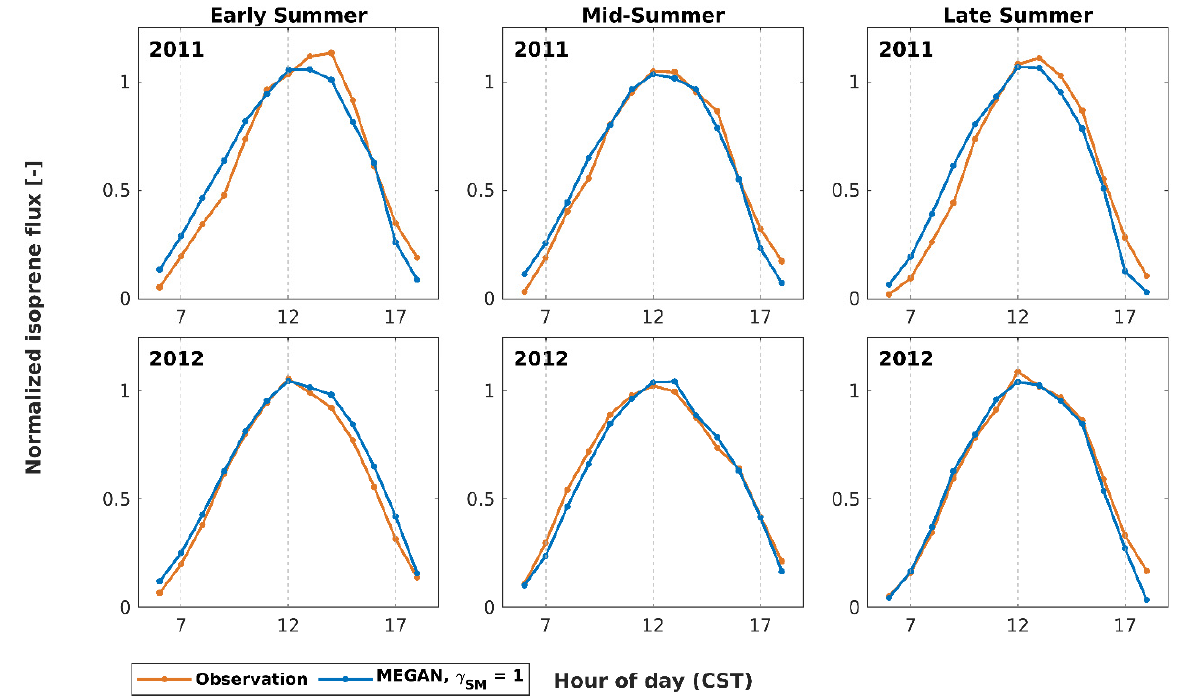
Figure 4. Observed and modelled diurnal cycles of isoprene fluxes normalized by the mean midday value (11–13 h) in years 2011 and 2012 over three periods: (i) early summer (May–June), (ii) mid- summer (July–August 10) and (iii) late summer (from August 10).